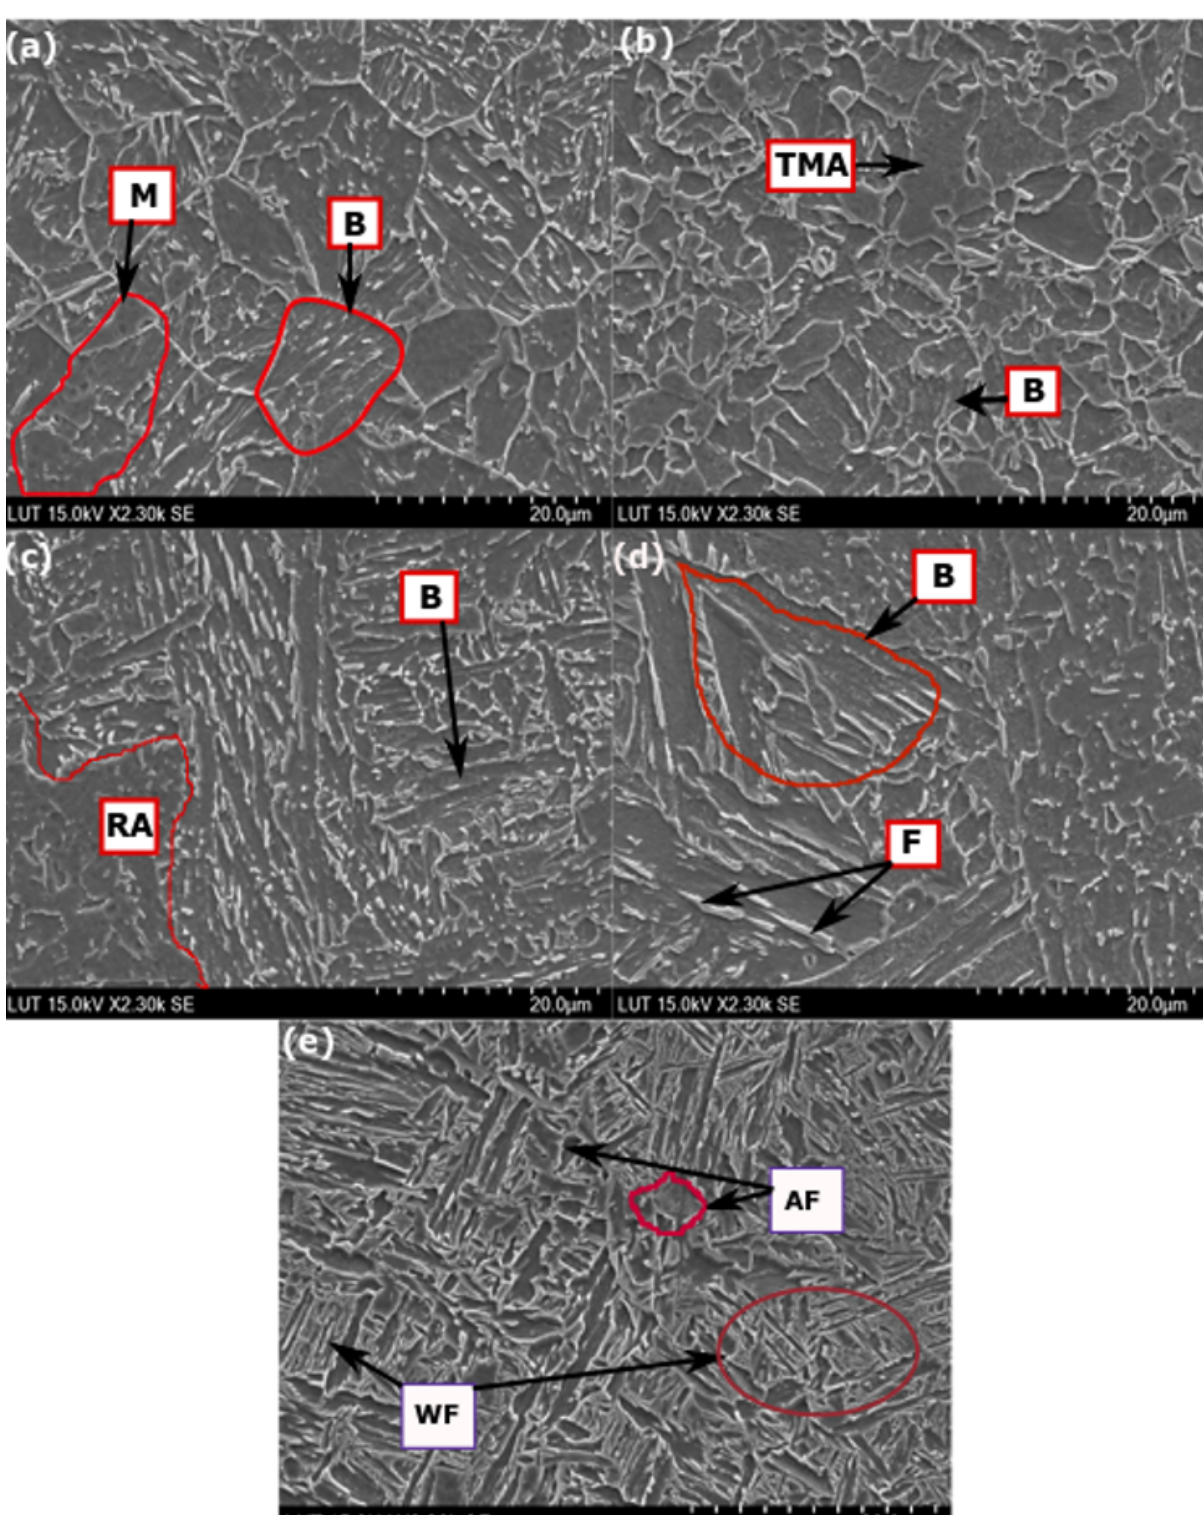
Figure 4: SEM micrograph, showing the microstructure of dissimilar S700MC/S960QC weld joint using overmatched filler wire: (a) FGHAZ of S700MC, (b) FGHAZ of S960QC, (c) CGHAZ of S700MC, (d) CGHAZ of S960QC, and